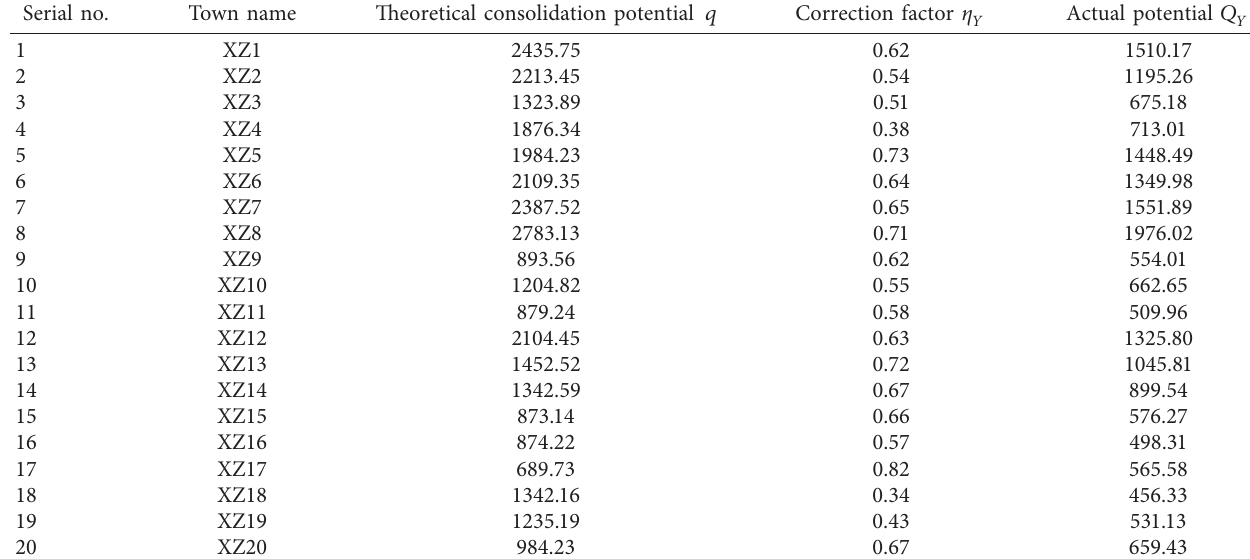
Table 9: Calculation results of rural residential land consolidation actual potential considering farmers’ willingness in 20 towns of Rugao City.